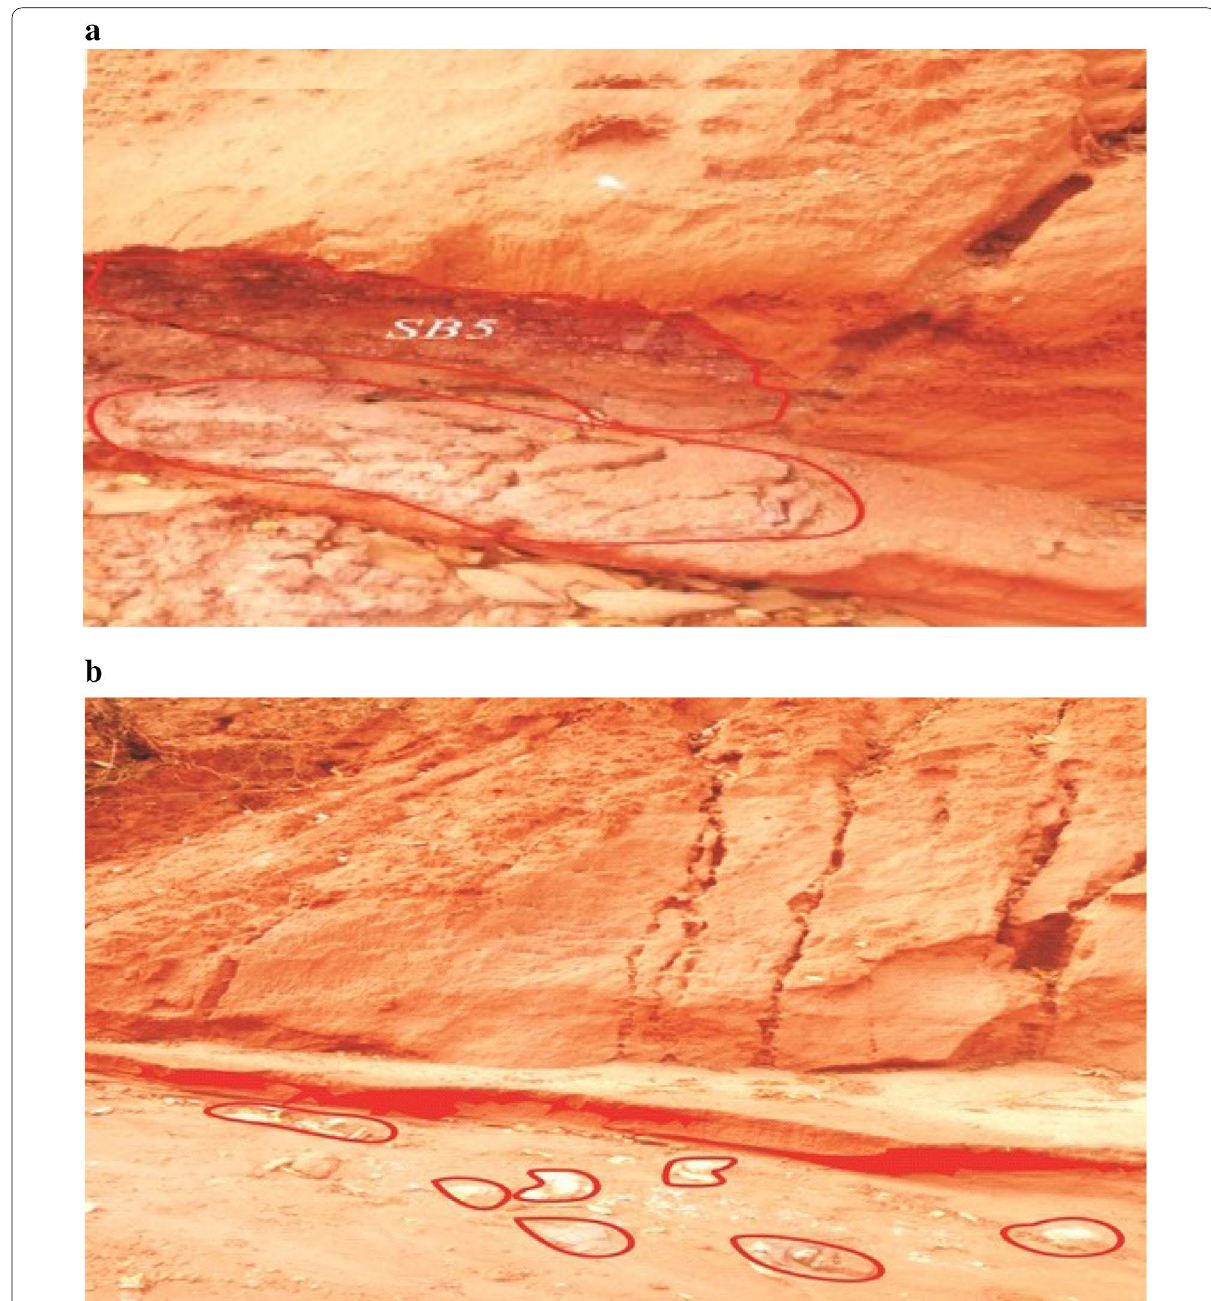
Fig. 8 a Shale/clay materials (SB5) acting as gliding surface in the study area (photo by Aigbadon). b Weathered shale/clay materials on the flood in the study area which act as the sliding plane in the affected areas (photo by